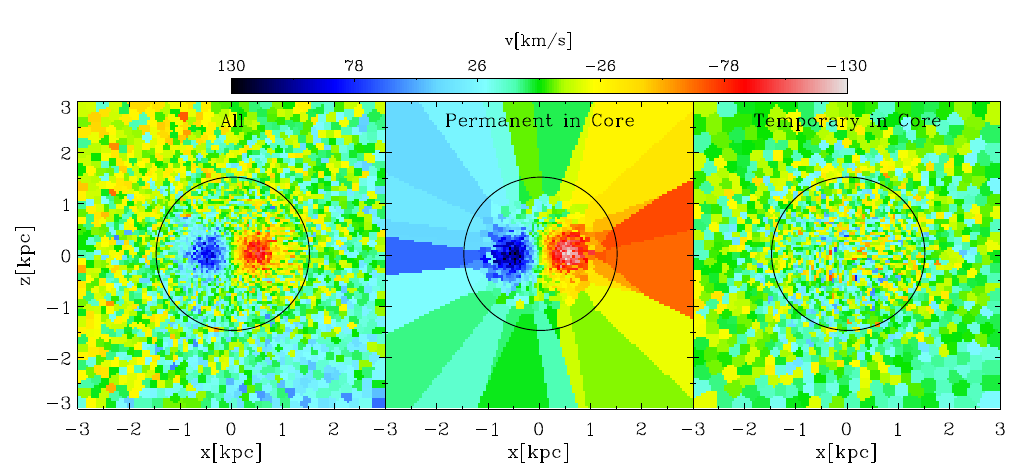
Figure 3. Left panel : LOSVD of the central 3 kpc in the x – z projection considering all stars in the line-of sight; central panel : LOSVD map of the central 3 kpc in the x – z projection taking into account stars that are determined to belong permanently to the KDC; right panel : LOSVD map of the central 3 kpc in the x – z projection including stars that only temporarily reside in the core. The panels share a common velocity scaling given in the color bar. The solid black circle indicates the core radius of r CORE = 1.5 kpc.